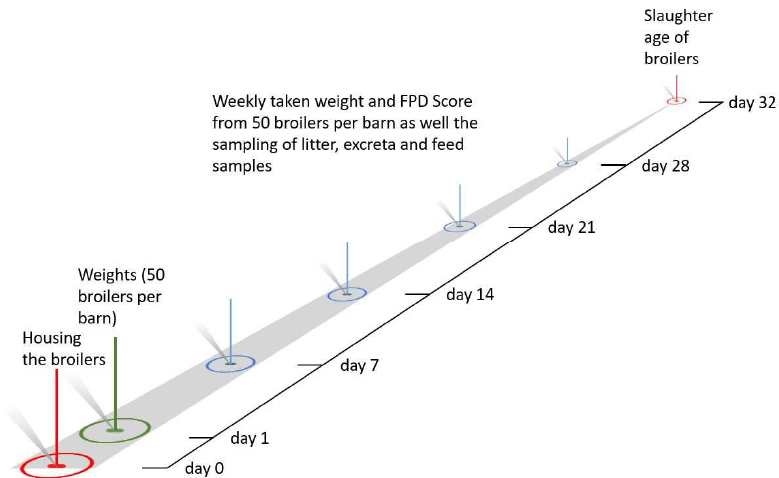
Figure 2. Sampling timeline for each barn in each run.